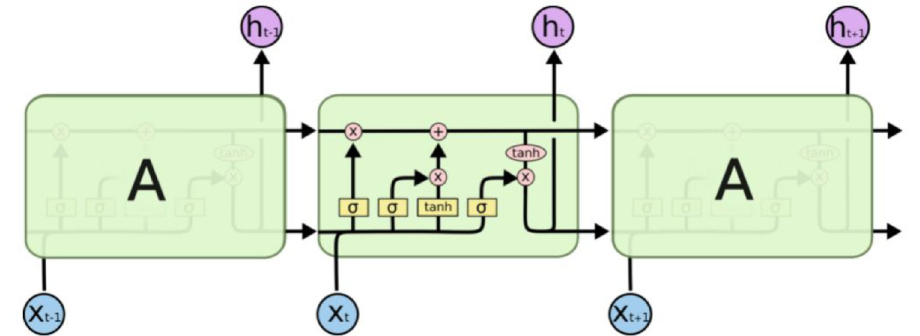
Fig 1. A sample LSTM unit. Credits: Christopher Olah